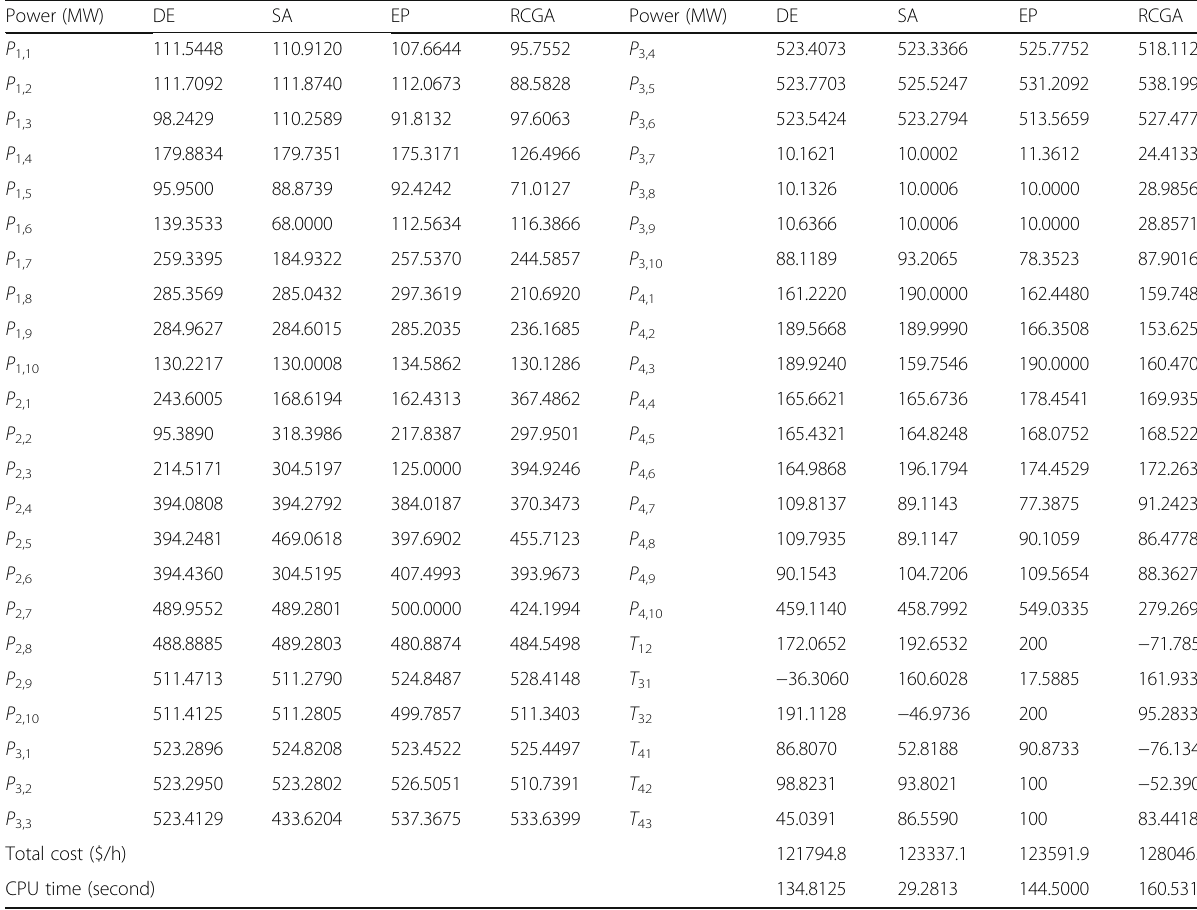
Table 3 Simulation results for test system